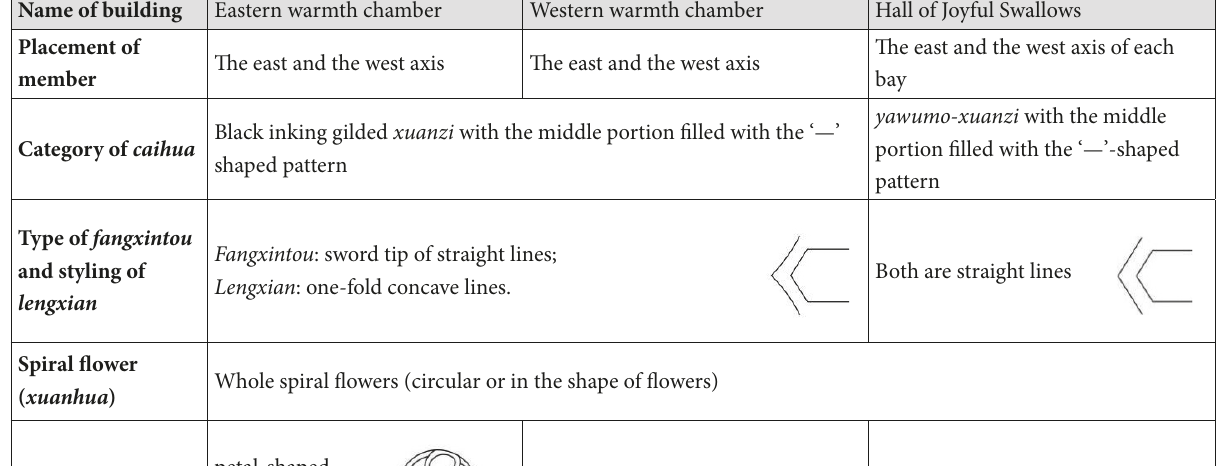
Table 2 Cross-reference of the patterns used in the decorative polychrome painting of the late Ming and the early Qing Dynasty in the eastern and western warmth chambers of the main hall and Hall of Joyful Swallows (Source: Hong Yang) Name of